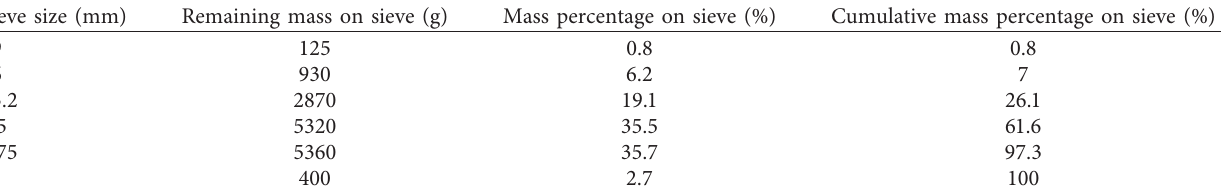
Table 3: Gradation range of coarse aggregate.